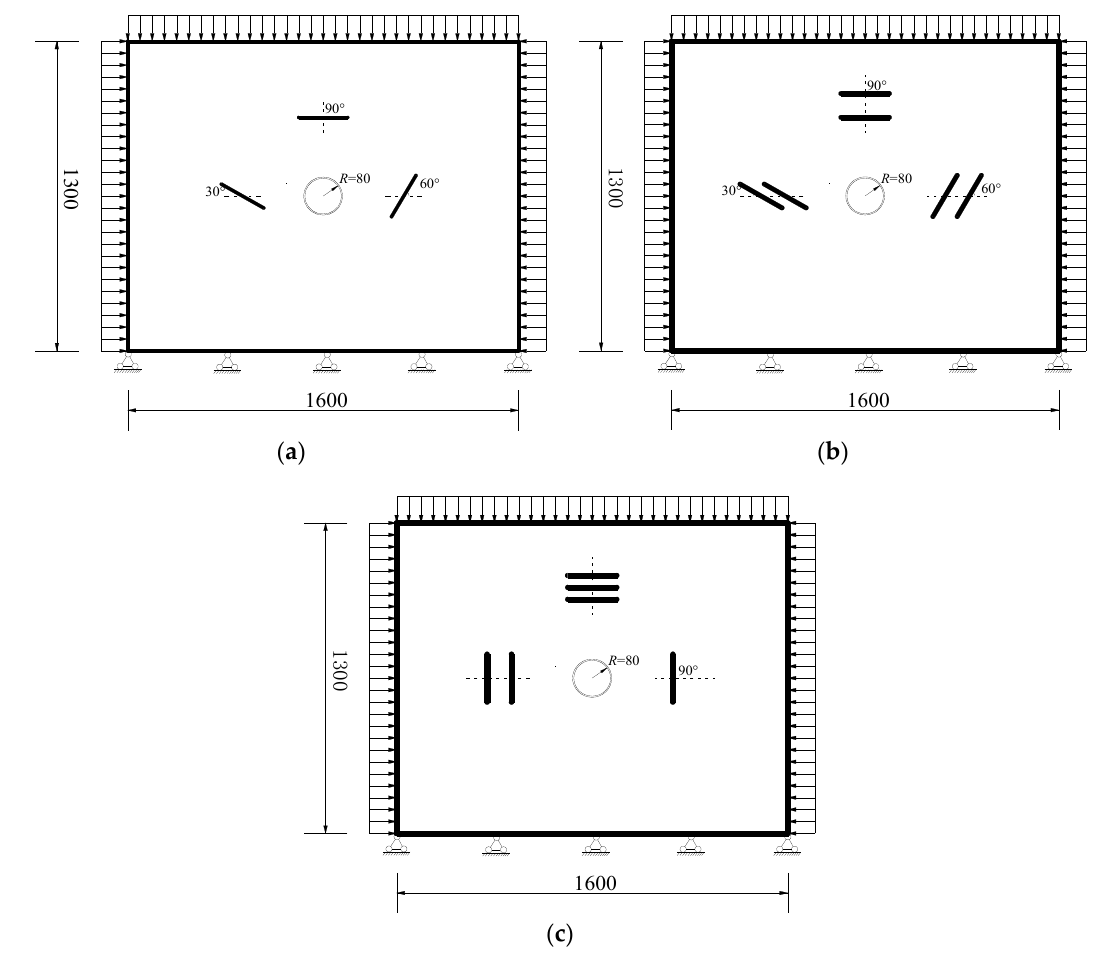
Figure 7. Numerical model of the different model test samples (unit: mm): ( a ) T1 sample; ( b ) T2 sample; ( c ) T3 sample.